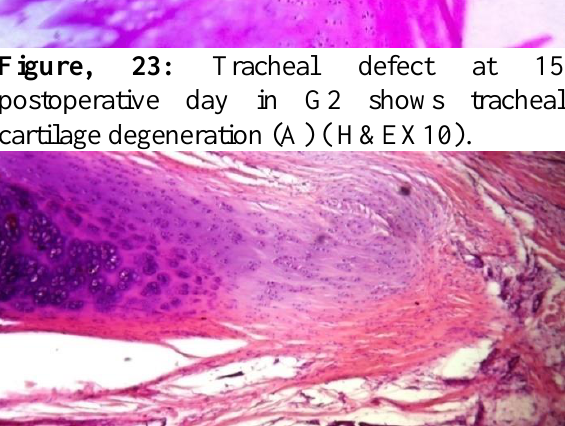
Figure, 23: Tracheal defect at 15 postoperative day in G2 shows tracheal cartilage degeneration (A) ( H&EX10).